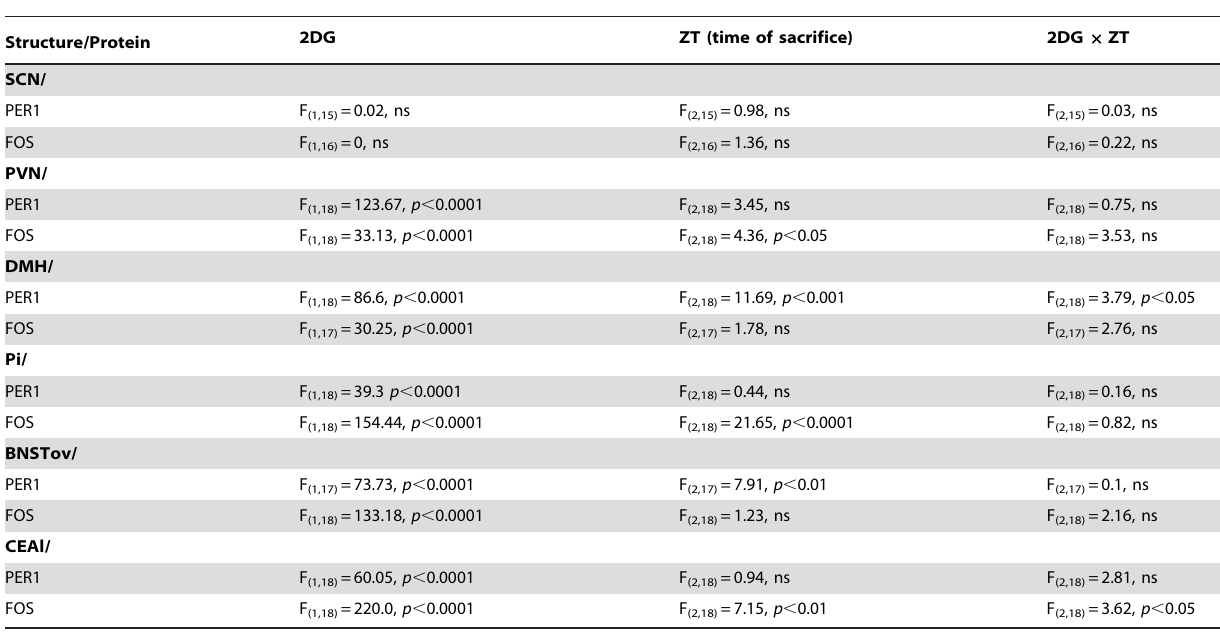
Table 4. Statistical analysis (ANOVA) of the effect of acute 2DG challenge on PER1 and FOS expression in hypothalamic and limbic brain